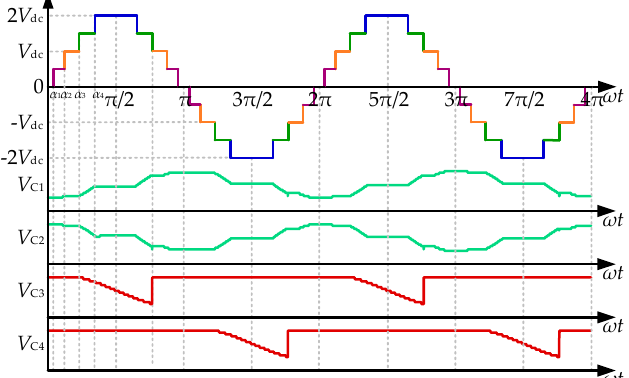
Figure 8. The capacitor working state curve within two cycles.